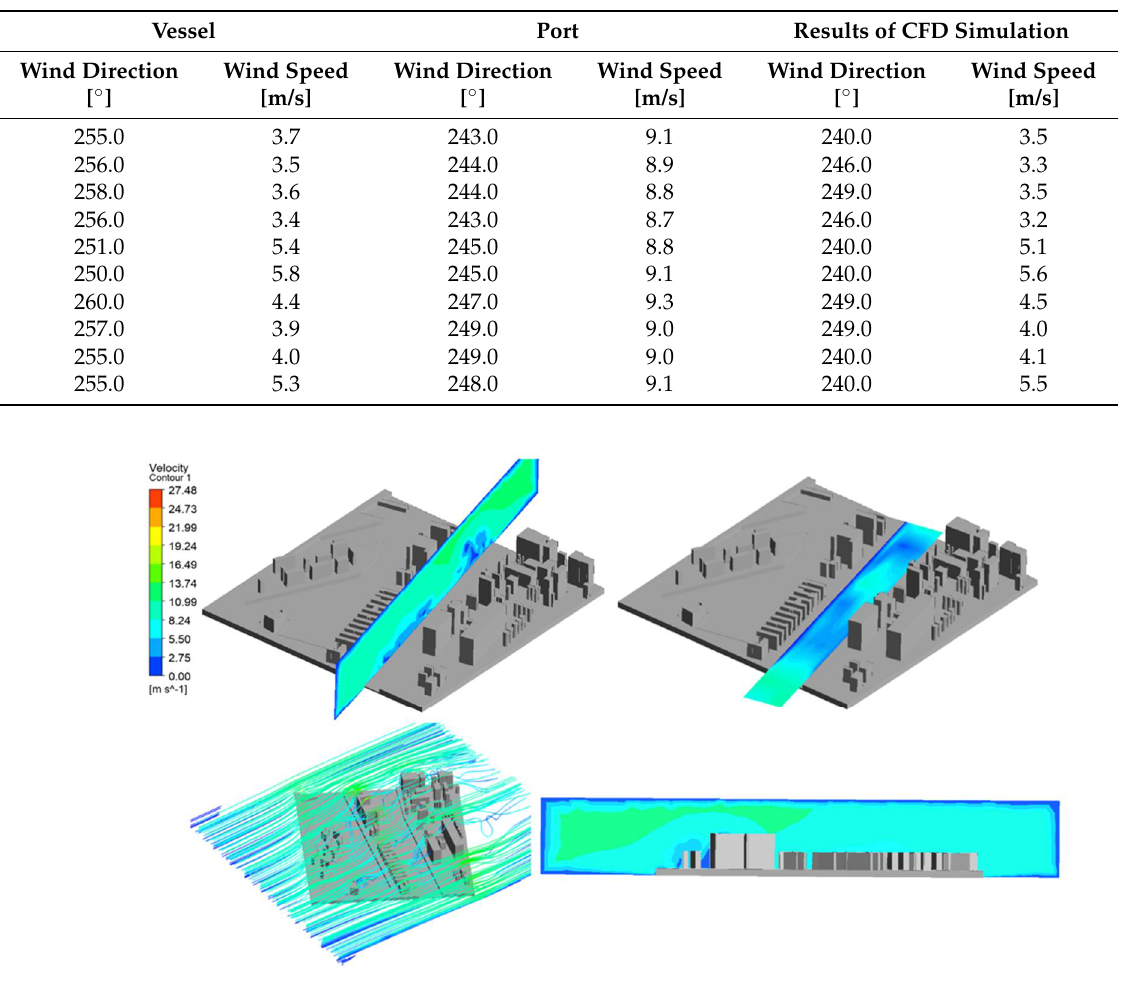
Table 3. CFD simulation results for the height of the port wharf.